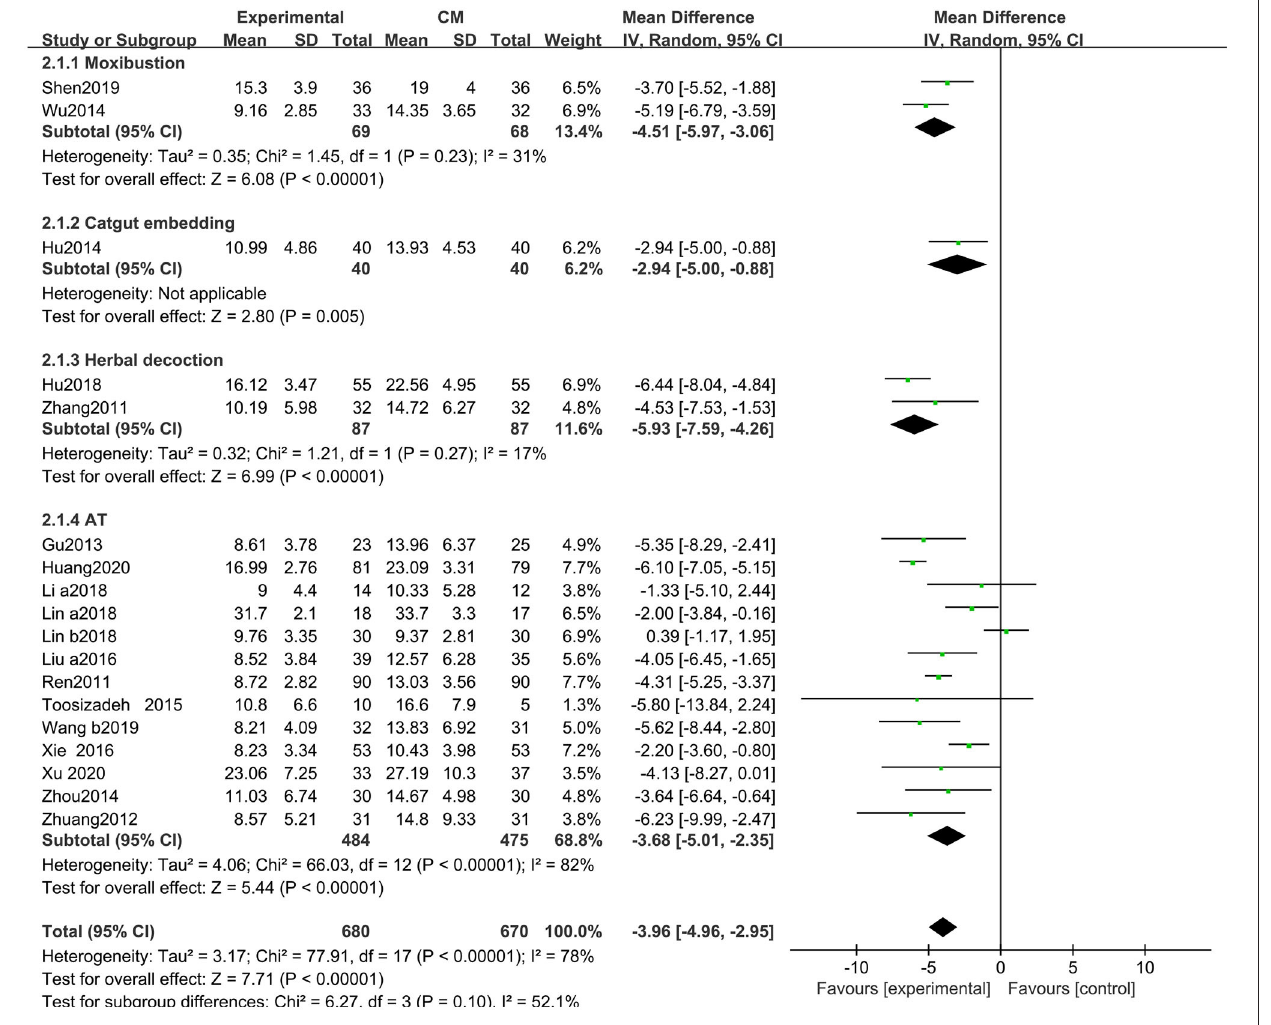
FIGURE 5 | Comparison of acupuncture related therapies in terms of